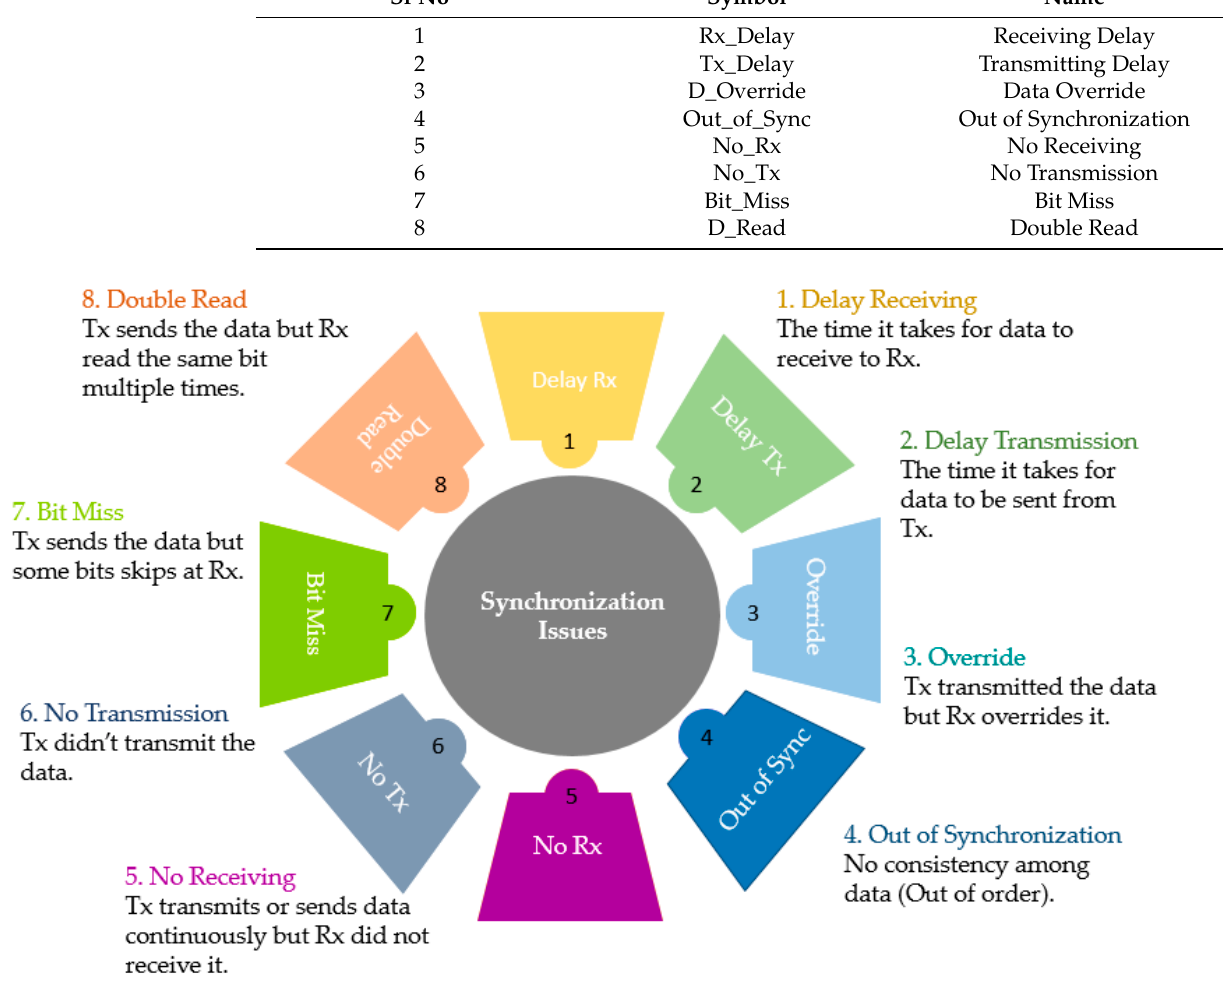
Figure 2. Detail of the synchronization errors during interprocessor communication.